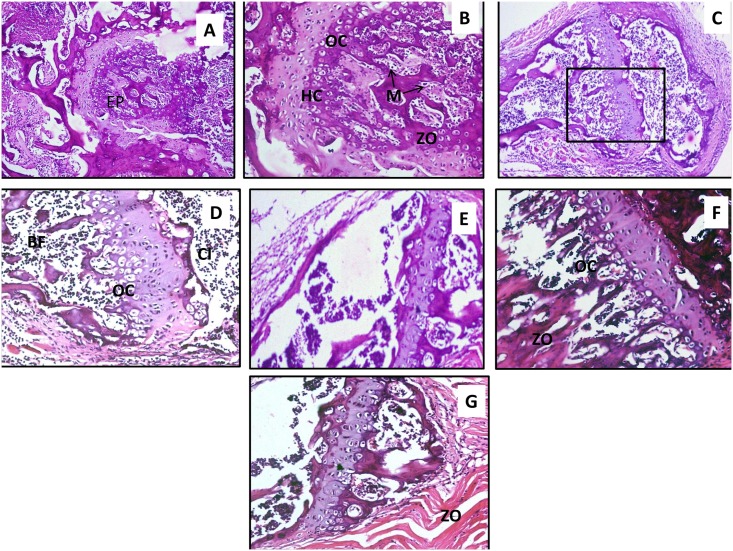
Photo micrograph of A) and B) healthy knee joint tissue of mice (H and E 100X and 200X) C) S. aureus infected post-operative knee joint tissue of mice implanted with naked wire (gr.1) on day 7 post infection (H and E 100 X) and D) Magnified view of the area (denoted in the rectangular panel) showing infected knee joint with heavy infiltration (H and E 200X). E) Photo micrograph of S. aureus infected post-operative knee joint tissue of mice implanted with phage coated wire (H-P) on day 7 post infection (H and E 100X) F) Photo micrograph of S. aureus infected post-operative knee joint tissue of mice implanted with linezolid coated wire (H-L) on day 7 post infection (H and E 200X) G) Photo micrograph of S. aureus infected post-operative knee joint tissue of mice implanted with dual coated wire (H-P-L) on day 7 post infection (H and E 100X).(HC: Hyaline cartilage; ZO: zone of ossification; EP: epiphyseal growth plate; OC/OB: osteocytes/osteoblasts; BF: bone fragmentation; CI: cellular infiltration).